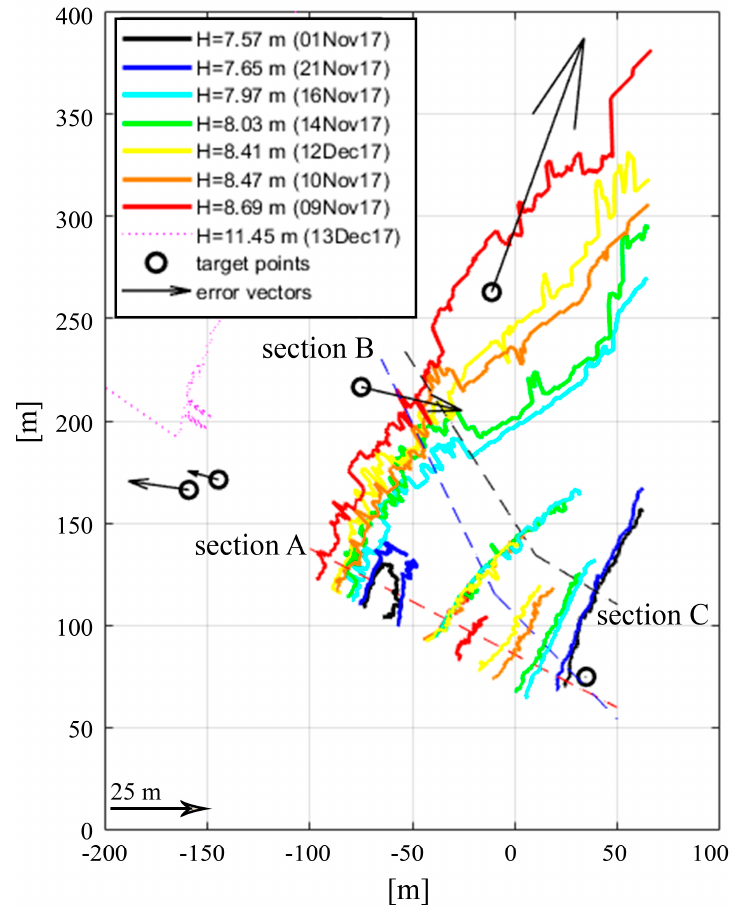
Figure 10. Deviations between actual and calculated positions of target points from the homography reported on the edge-of-water lines map. Error arrows are double-scaled.